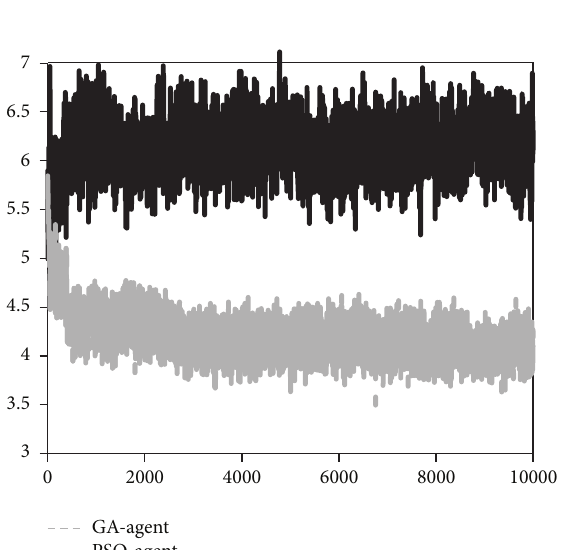
Figure 8: DE-agent tests.